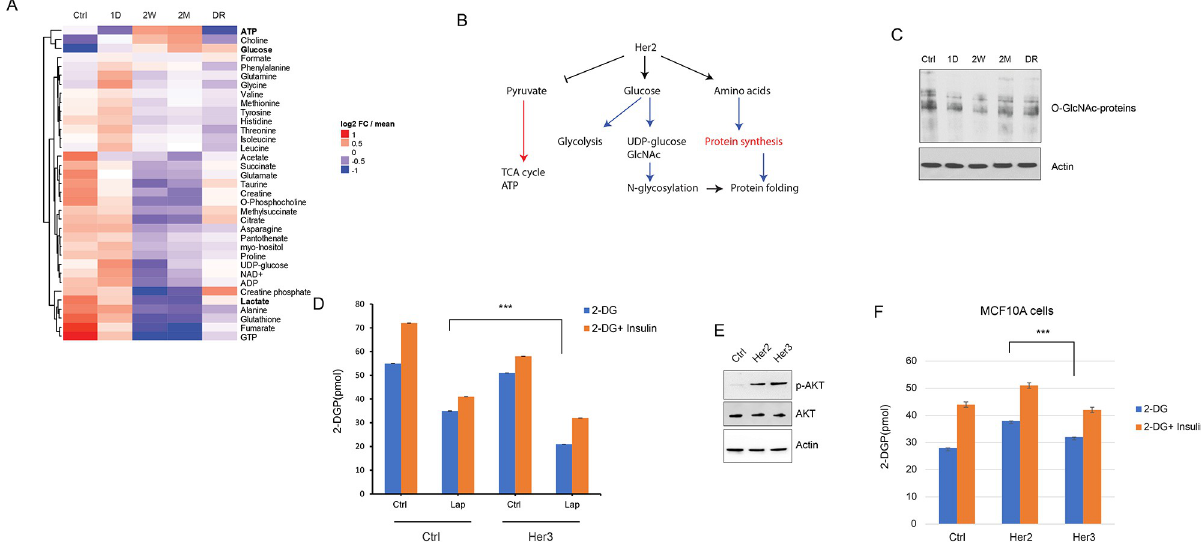
Fig 4. Metabolomic reprogramming during chronic lapatinib treatment. A) Heatmap of the most notable altered intracellular metabolites between the different stages of 1 μ M lapatinib treatment, measured by NMR mass spectrometry. B) A model summarizing the effect of chronic lapatinib treatment on the glucose, energy and amino acid metabolism. Blue lines: reduced flux, red lines: increased flux at the relapse stage (2M). C) Western blot of O-GlcNAc-conjugated protein levels in the indicated conditions. O-GlcNAc levels may serve as a readout of the N-linked hexosamine (GlcNAc) levels. D) Intracellular glucose uptake assay measuring 2-deoxyglucose uptake with and without insulin after lapatinib treatment in SKBR3 cells. Her3 overexpression is unable to rescue the glucose uptake inhibition of lapatinib treatment. E) Overexpression of Her2 or Her3 in the non-transformed MCF10A cells induces similar activation of downstream pathways (p-Akt). F) Glucose uptake rates with control, Her2 or Her3 overexpression in MCF10A cells. Statistics: error bars show standard deviations from 2 replicate samples. Data are representative of 2 independent experiments. ��� : P < 0.01 with student’s t-test. Densitometric quantitation of the immunoblotting data are provided in S1 Table.